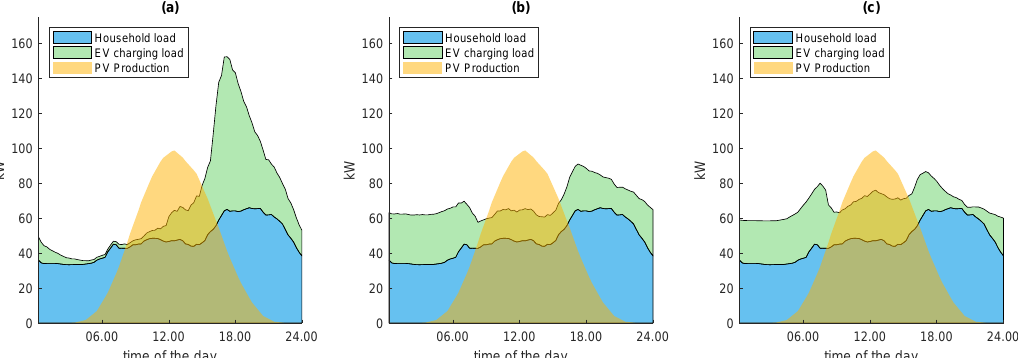
Figure 7. Mean daily load profile for 100 households with R = 0.5 with the ( a ) uncontrolled charging scheme, ( b ) distributed smart charging scheme, and ( c ) centralized charging